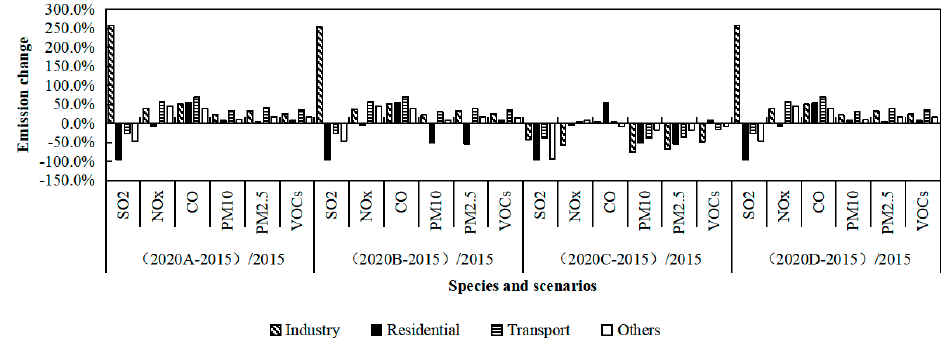
Figure 2. Emission changes in sectors in di ff erent scenarios in the whole city (Guangzhou).